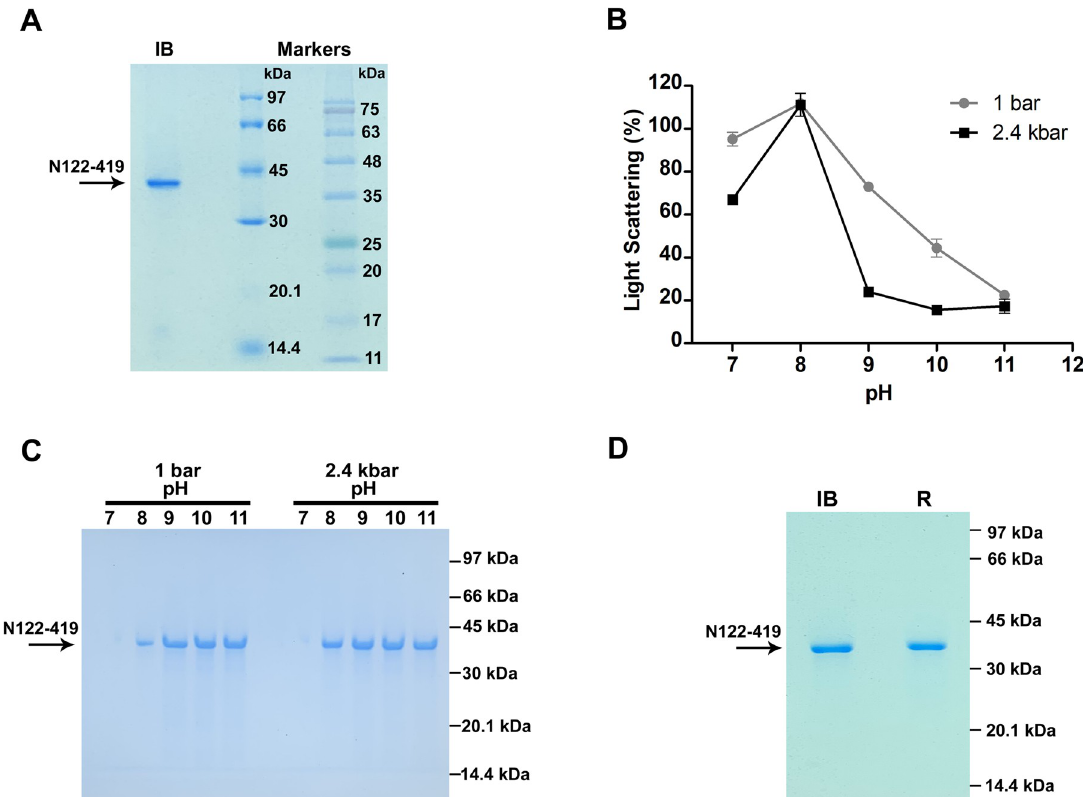
Fig 2. Compression at 2.4 kbar and alkaline pH promote solubilization of N122-419-IB. Suspensions of N122-419-IB were subjected to 2.4 kbar for 90 min or to 1 bar for 4 h. A, SDS-PAGE of N122-419-IB; B, Light scattering (LS) vs pH. Values are expressed as LS mean ± SD. The LS value, obtained for the suspension at a pH 7.0 at 1 bar was considered to be 100%. Each condition was analyzed in duplicate; C, SDS-PAGE of fractions of N122-419-IB that were solubilized at different pH; D, SDS-PAGE of N122-419-IB (IB) and refolded N122-419 (R). All samples were reduced. The results are representative of 2 independent